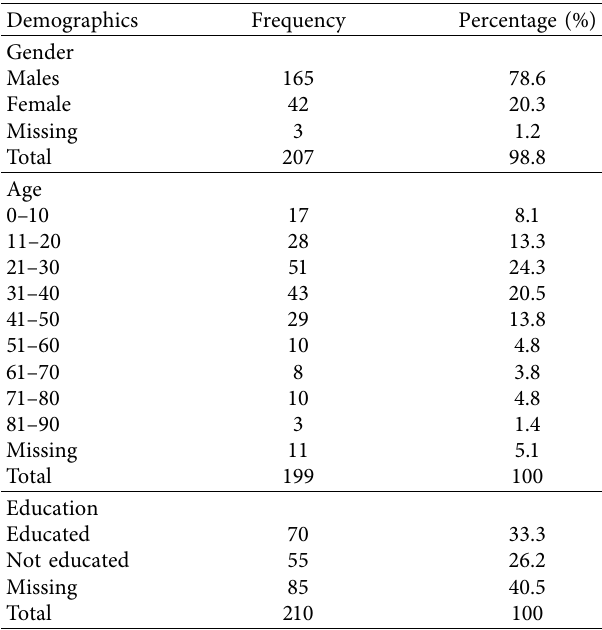
Table 1: Patient demographics.